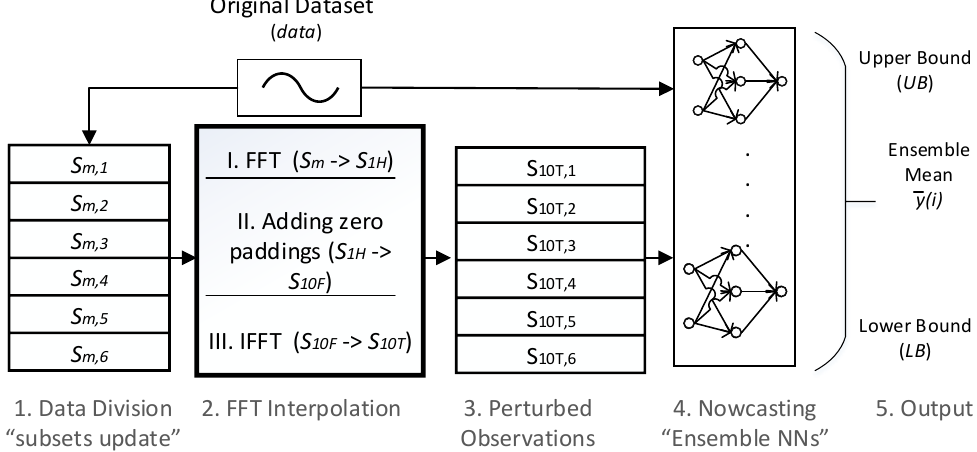
Figure 6. Proposed nowcasting procedure. The deterministic (ensemble mean) and the probabilistic (upper and lower bounds) values are obtained from the output of each member in the ensemble network.